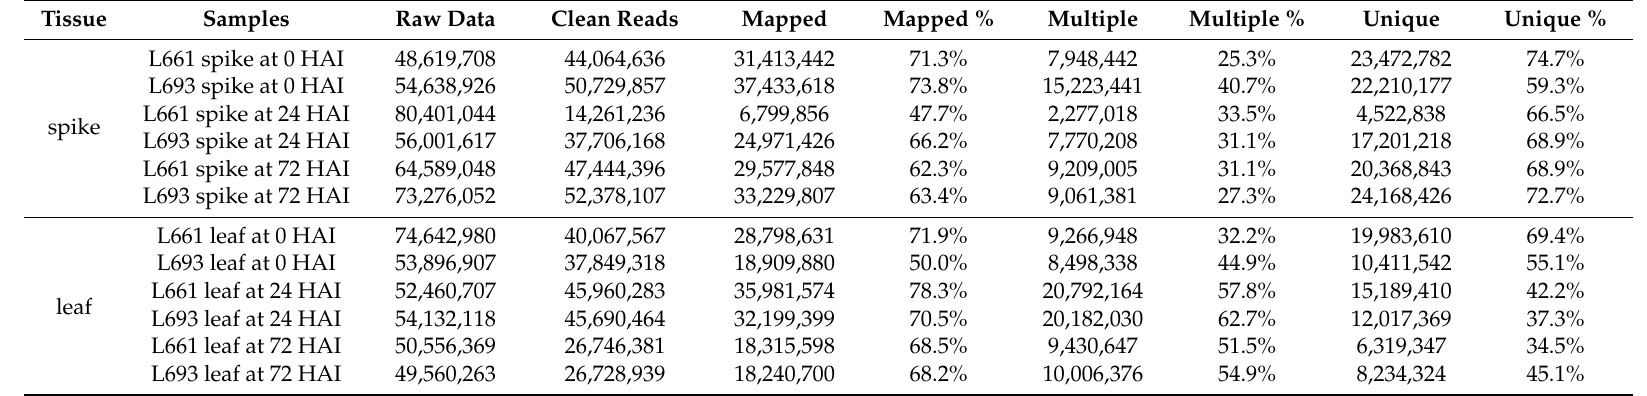
Table 1. RNA-seq read